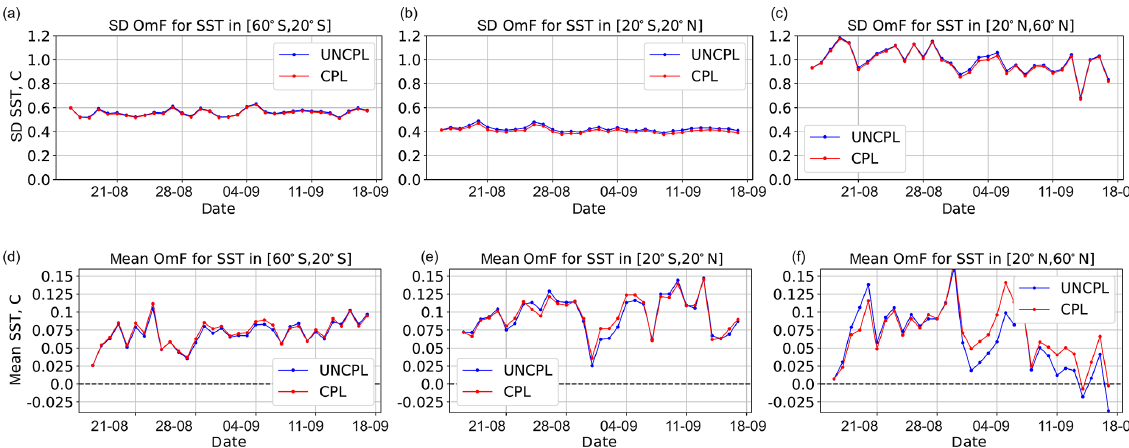
Figure 8. Evolution of sea surface temperature OmF standard deviation (a, b, c) and mean OmF (d, e, f) ( ◦ C) with respect to SST data assimilated within the separate SST DA component. The statistics are computed for UNCPL (blue curves) and CPL (red curves) in three latitude bands: southern extratropics between 20 and 60 ◦ S (a, d) , tropics, between 20 and 20 ◦ N (b, e) , and northern extratropics between 20 and 60 ◦ N (c, f) . The statistics are computed for the 12h forecast and the corresponding data.